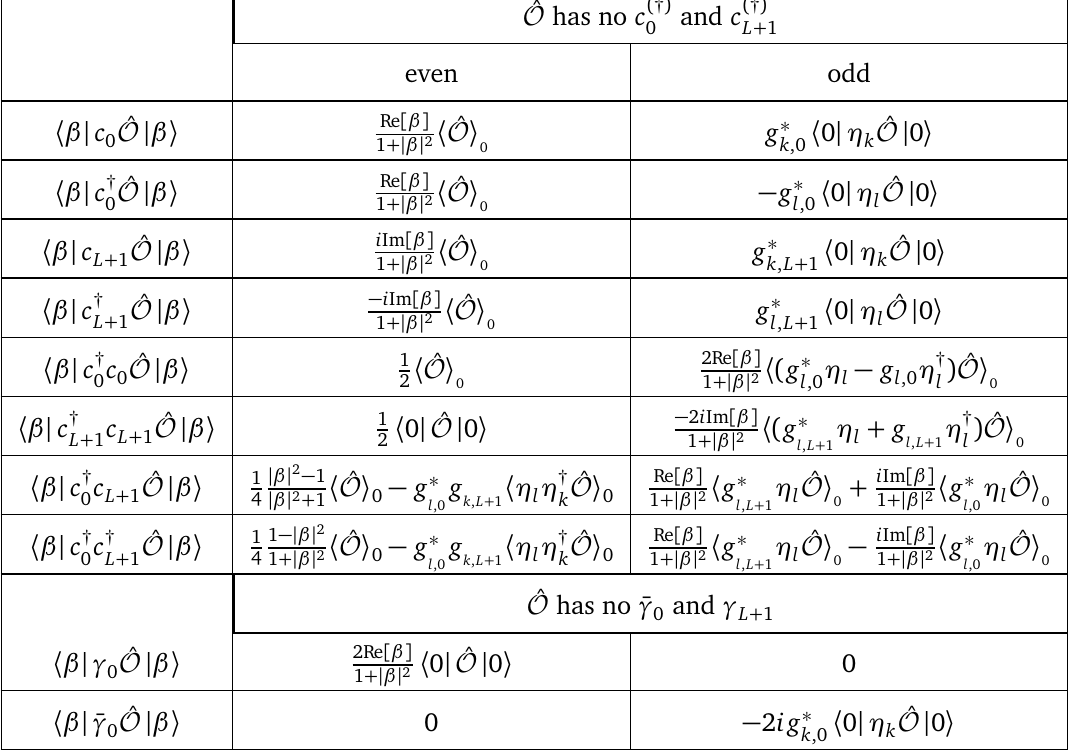
Table 1: Terms “even" and “odd" mean that the operator ˆ O contains even or odd products of c -operators. Also, k , l (cid:54) = 0, L + 1 and the Einstein summation rule is as- sumed. The notation 〈···〉 stands for the expectation value calculated in the vacuum 0